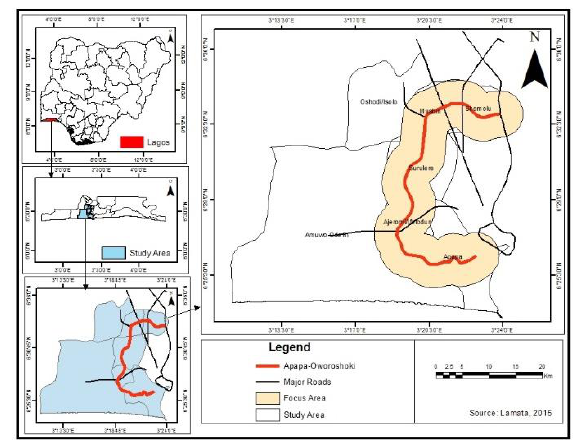
Figure 2: Study Area: Apapa-Oworoshoki corridor 2.